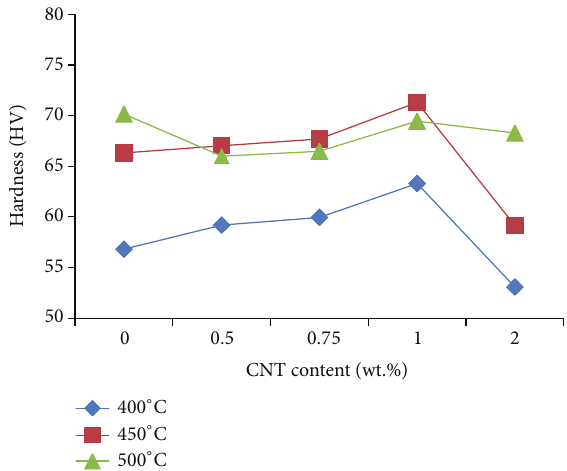
Figure 9: Microhardness of CNT reinforced Al6061 nanocompos-